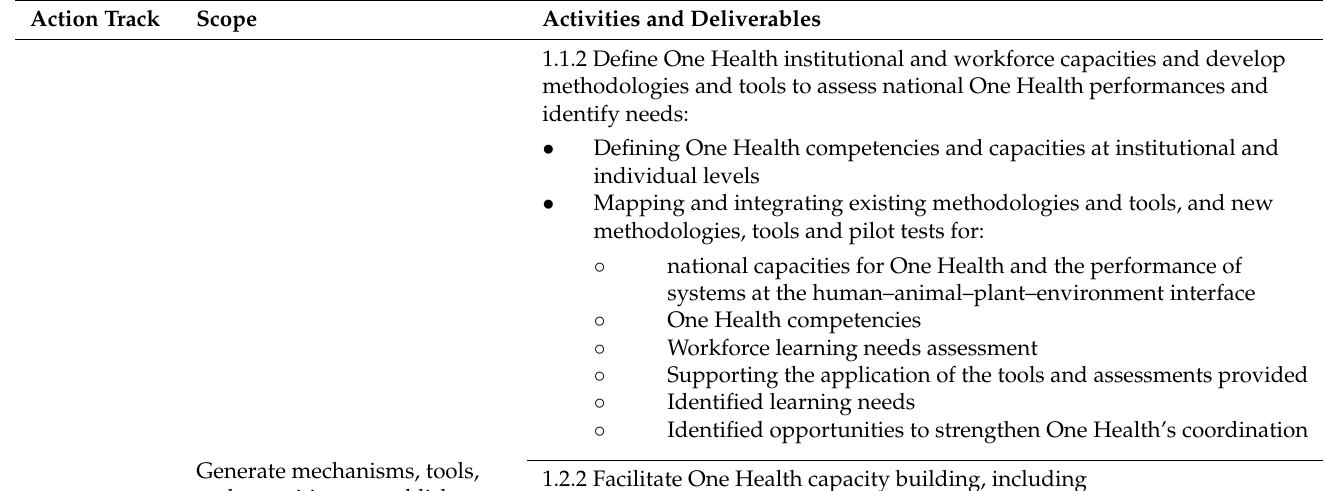
Table 1. Workforce-related Action Tracks of the FAO, UNEP, WHO, and WOAH’s ‘One Health Joint Plan of Action (2022–2026)’